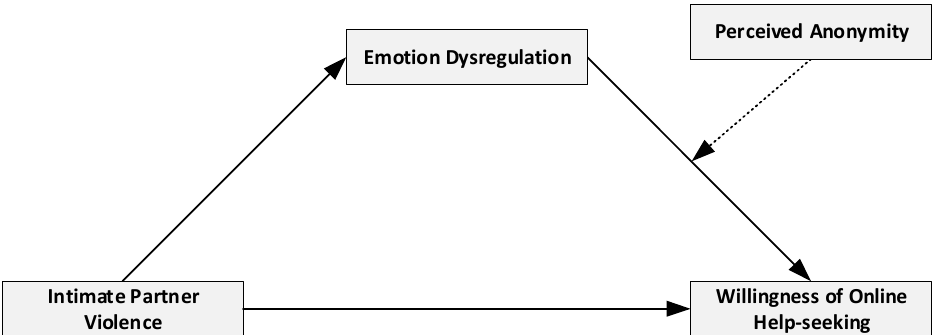
Figure 1. The proposed moderated-mediation model of the relationship between IPV and online help-seeking.